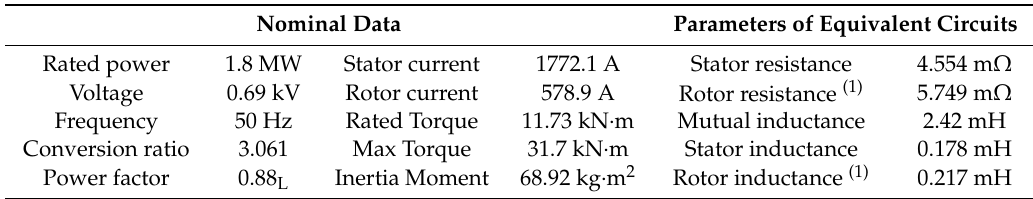
Table 2. Nominal data and parameters of DFIM in wind turbine. Nominal